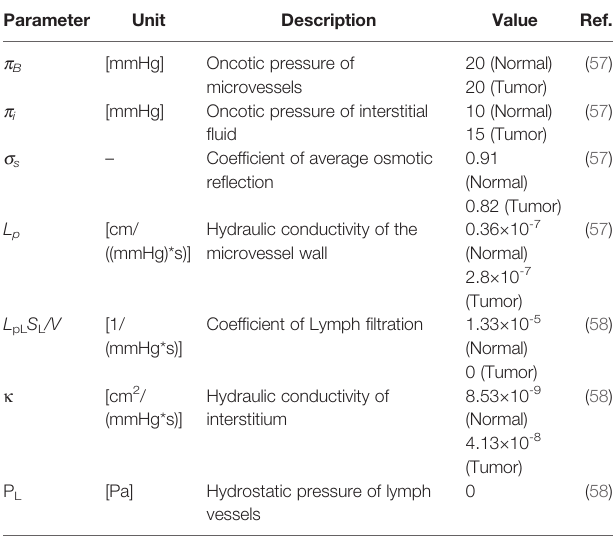
TABLE 2 | Parameters of interstitial transport used in numerical simulations.